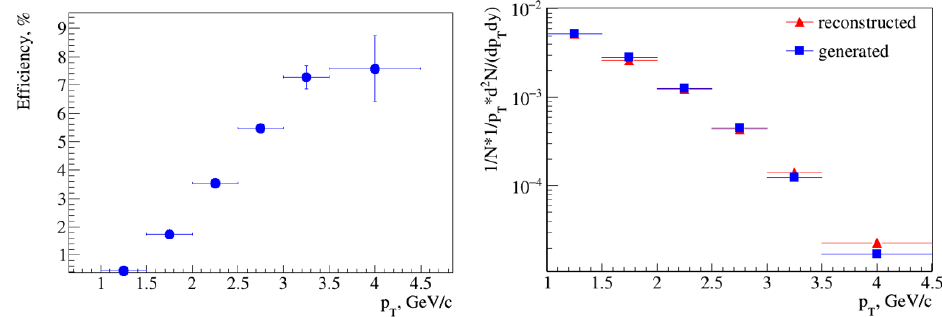
Figure 5. Left panel: efficiency of hypertriton reconstruction in transverse momentum intervals. Right panel: invariant transverse momentum spectra of hypertritons from Bi+Bi collisions. The reconstructed one is plotted by red symbols, the initial one from the model is shown by blue